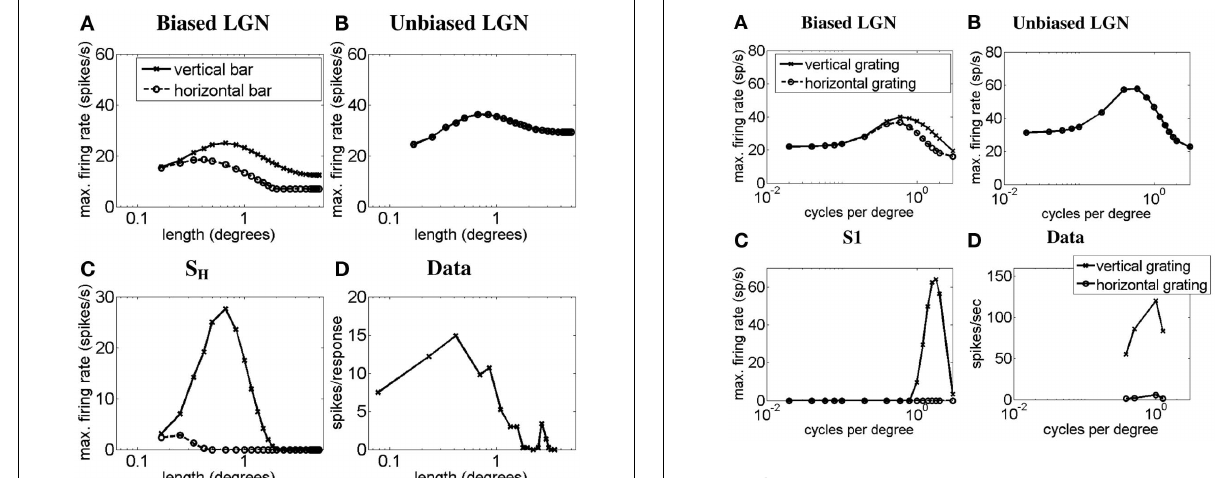
FIGURE 4 | Spatial frequency-response function of the simple cell S1 with length summation. The plots show simulated SF-response functions of (A) an ON LGN cell with a vertically biased center and a weak isotropic inhibitory surround, (B) an ON LGN cell with an isotropic center and a strong isotropic inhibitory surround, and (C) the corresponding vertically oriented simple cell S1 in response to a vertical grating (solid lines) and a horizontal grating (dashed lines). (D) The SF-response function of a real simple cell with length summation in response to vertical and horizontal gratings (Data adapted from Hammond and Pomfrett, 1990). In (A–D) the y -axis represents the maximum firing rate in spikes/seconds, and the x -axis represents the SF in cycles per degree